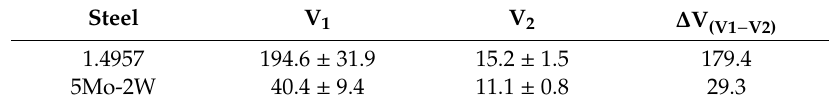
Table 2. Volume loss ( ∆ V) of the wear tracks shown in Figure 8 measured by CLSM (in 10 − 3 mm 3 ).